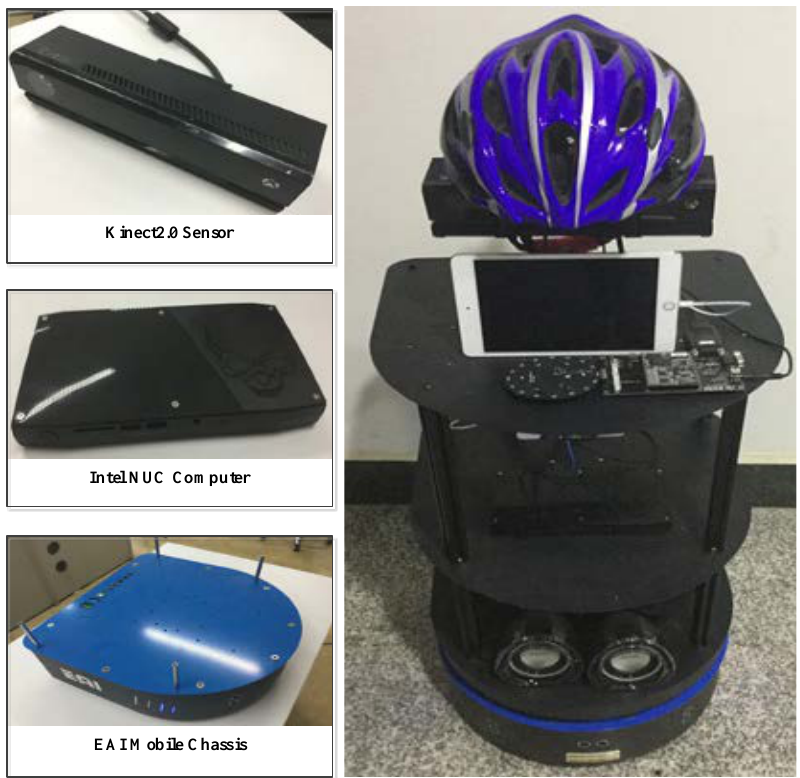
Figure 3. The used social robot platform MAT.